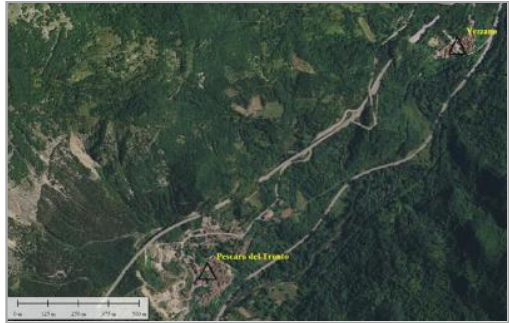
Figure 1 : Territorial framework of studied area (ad- ministrative territory of Arquata del Tronto) with in- dication of the small villages of Pescara del Tronto and Vezzano.